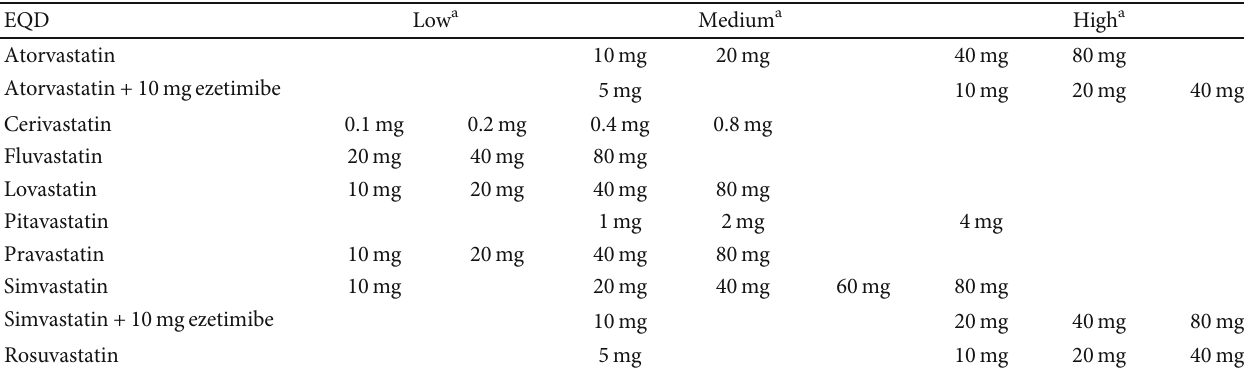
Table 1: Equalized statins doses. Doses of statins are combined such that they have approximately the same e ff ect on lowering LDL-C. EQD Low a